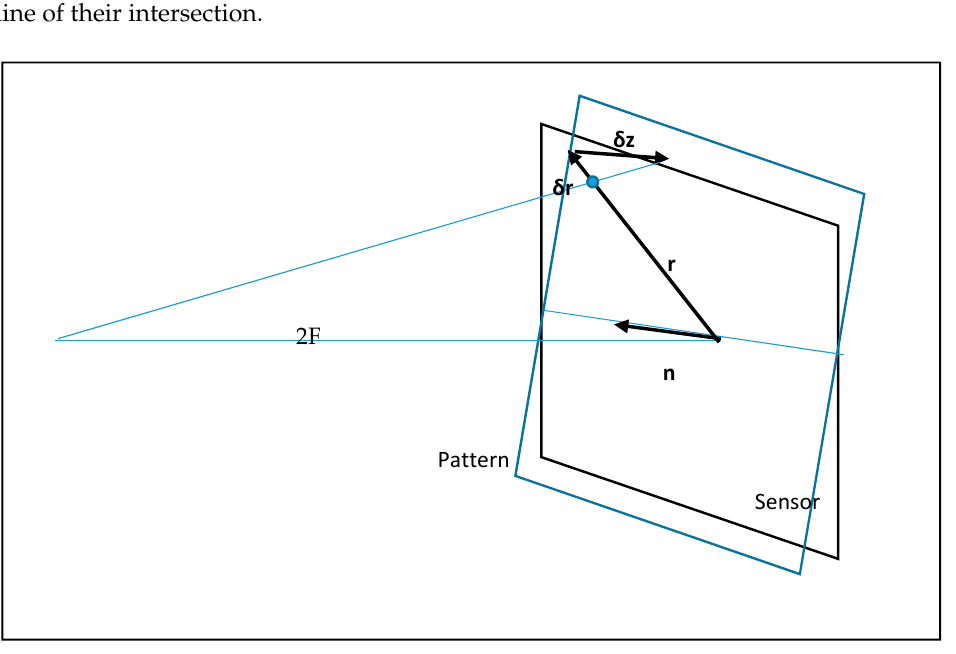
Figure 2. Combining the image sensor and the pattern in the reverse course.